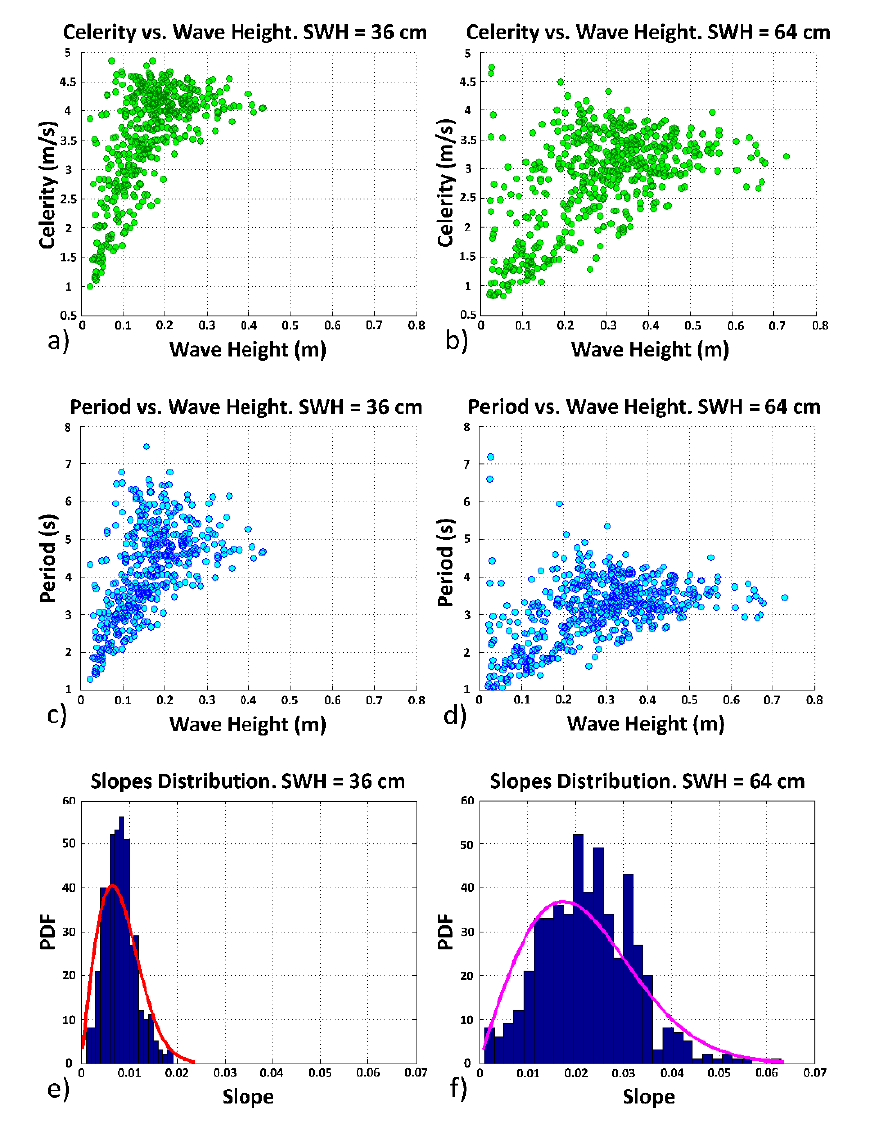
Figure 4. ( a ) Correlation celerity vs. wave height for a SWH = 36 cm; ( b ) correlation celerity vs. wave height for a SWH = 64 cm; ( c ) correlation period vs. wave height for a SWH = 36 cm; ( d ) correlation period vs. wave height for a SWH = 64 cm; ( e ) slope distribution for a SWH = 36 cm; ( f ) slope distribution for a SWH = 64